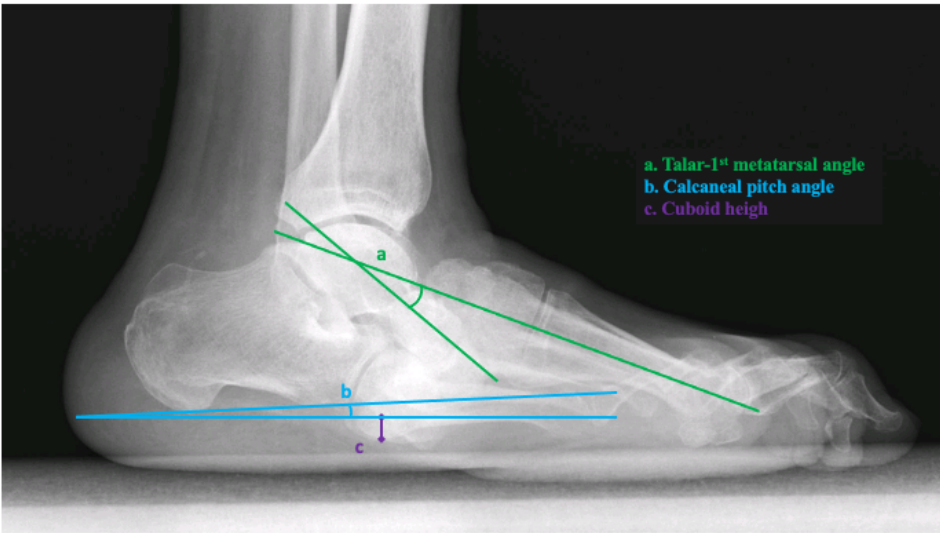
Figure 1. Radiographic measurements in the weight-bearing lateral X-ray. Legend. a, talar-first metatarsal angle (°); b, calcaneal pitch angle (°); c, cuboid height (mm).